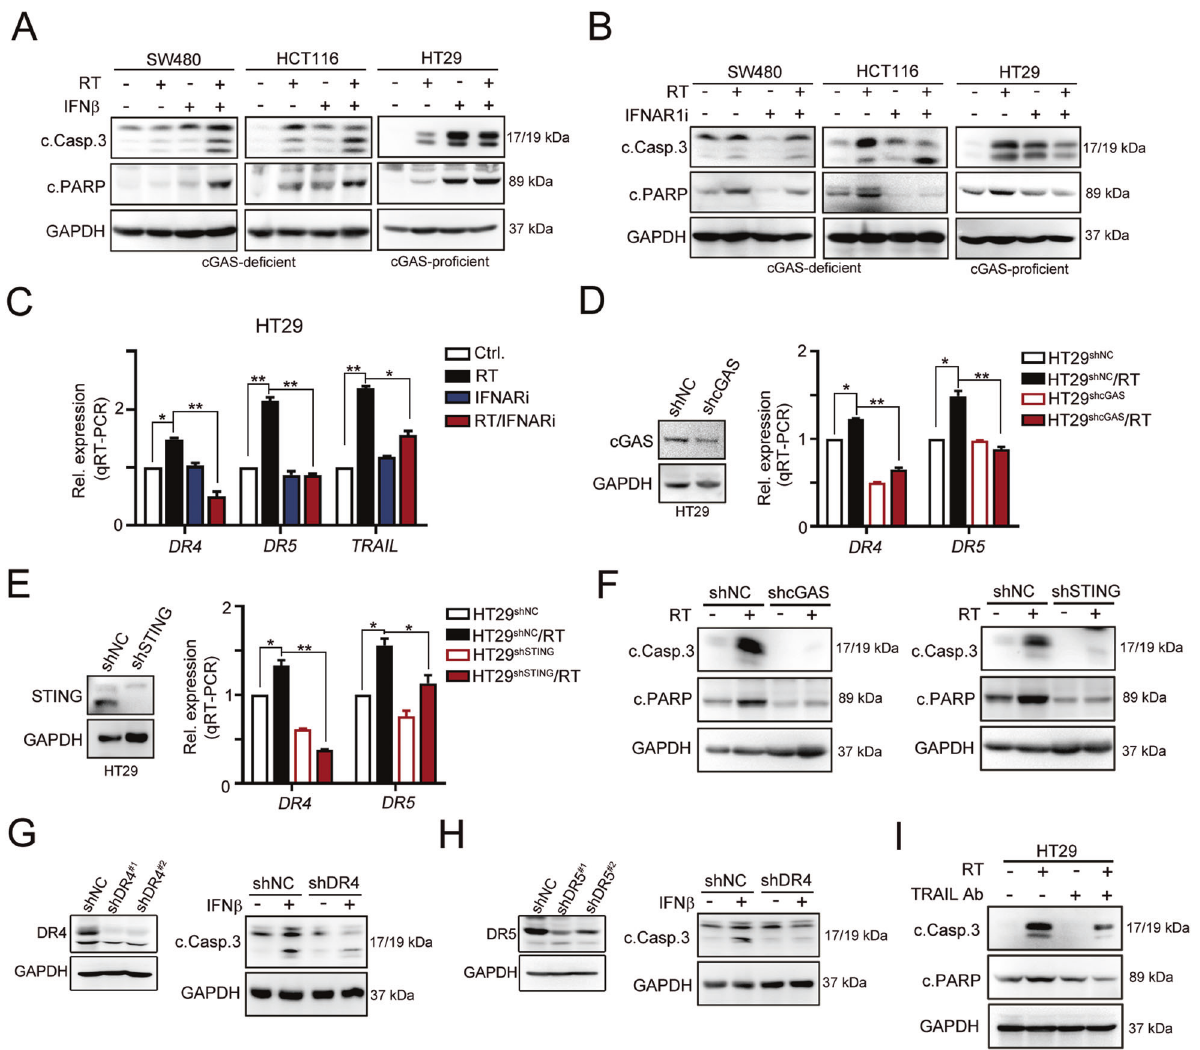
Fig. 2 Type I IFN signi fi cantly enhanced radiotherapy-induced cell death by TRAIL signaling. A Three colorectal cancer cells were treated with IFN β (10 ng/mL) and RT (5 Gy) for 24 h. The level of caspase-3 and PARP cleavage was evaluated by western blot. B Three colorectal cancer cells were treated with IFNAR1 (10 μ M) and RT (5 Gy) for 24 h. The level of caspase-3 and PARP cleavage was evaluated by western blot. C HT29 (cGAS/STING-pro fi cient) cells were treated with IFNAR1 (10 μ M) and RT (5 Gy) for 24 h. The mRNA level of DR4 , DR5 , and TRAIL was evaluated by qRT-PCR (mean ± SEM, n = 3). * p < 0.05 and ** p < 0.01. D HT29 shNC and HT29 shcGAS cells were treated with RT (5 Gy). The mRNA level of DR4 , DR5 , and TRAIL was evaluated by qRT-PCR (mean ± SEM, n = 3). * p < 0.05 and ** p < 0.01. E HT29 shNC and HT29 shcGAS cells were treated with